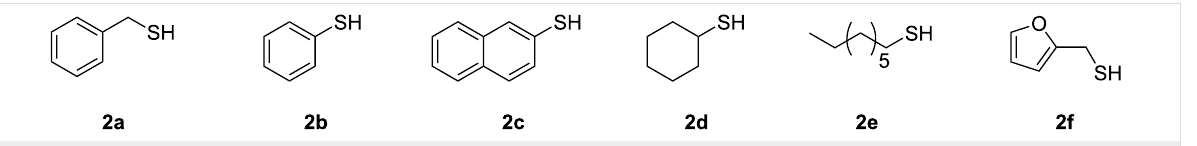
Figure 1: Overview of the structures of the alcohols 1a–i used in the present work.